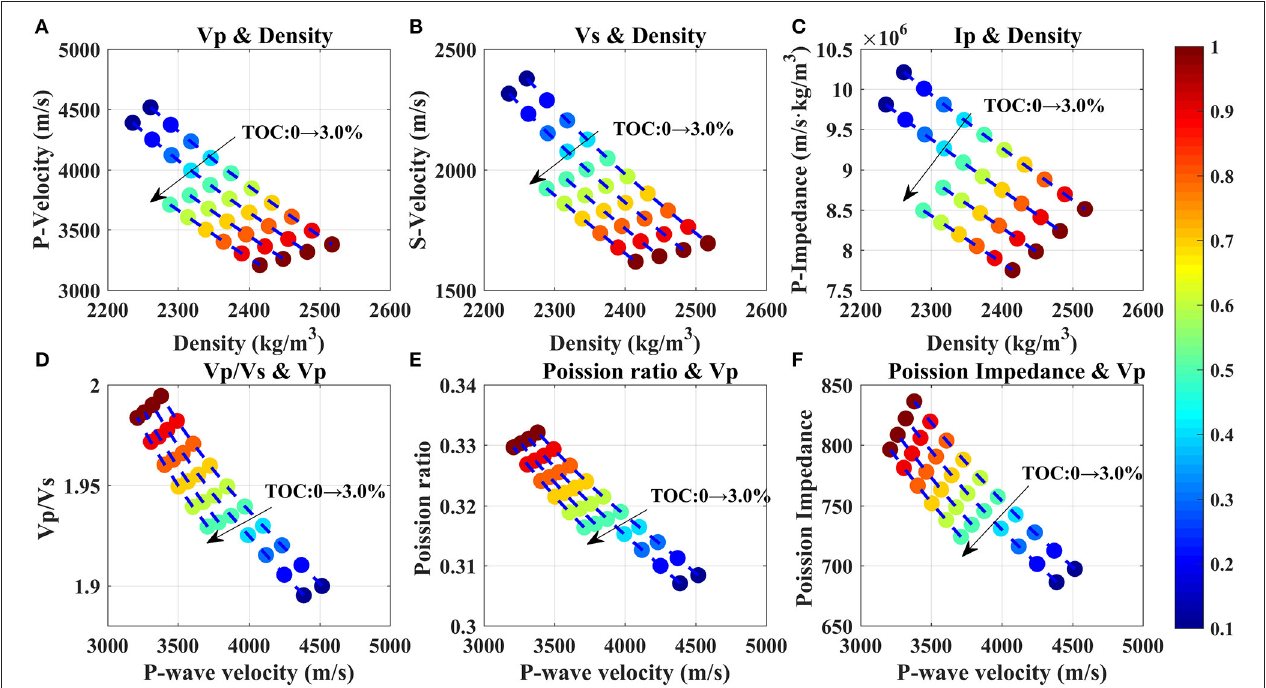
FIGURE 6 | Crossplot of elastic parameters versus mud content at different TOC values based on the rock physical model of the mud-rich source rock. (A) V p and ρ , (B) V s and ρ , (C) I p and ρ , (D) V p / V s and V p , (E) Poisson’s ratio and V p , (F) Poisson impedance and V p . The color bar on the right represents the mud content.